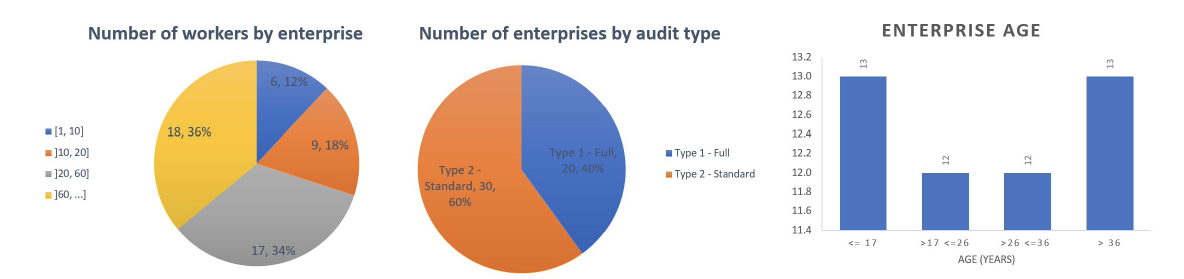
Figure 5. Enterprises’